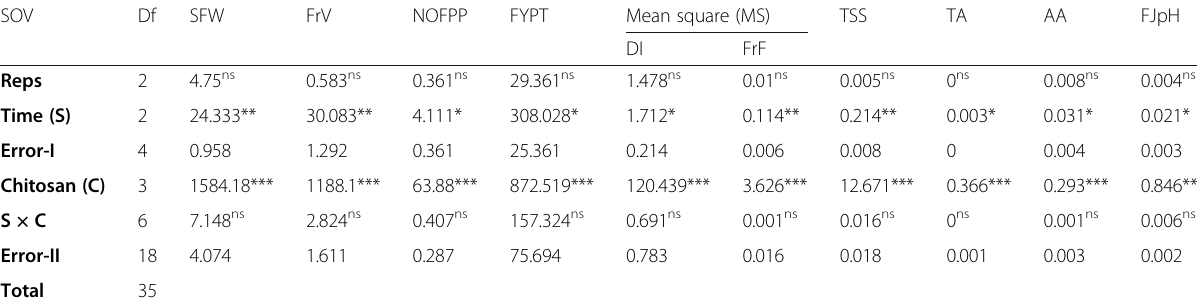
Table 1 Mean square value of various attributes of peach influenced by chitosan concentration and its time of application SOV Df SFW